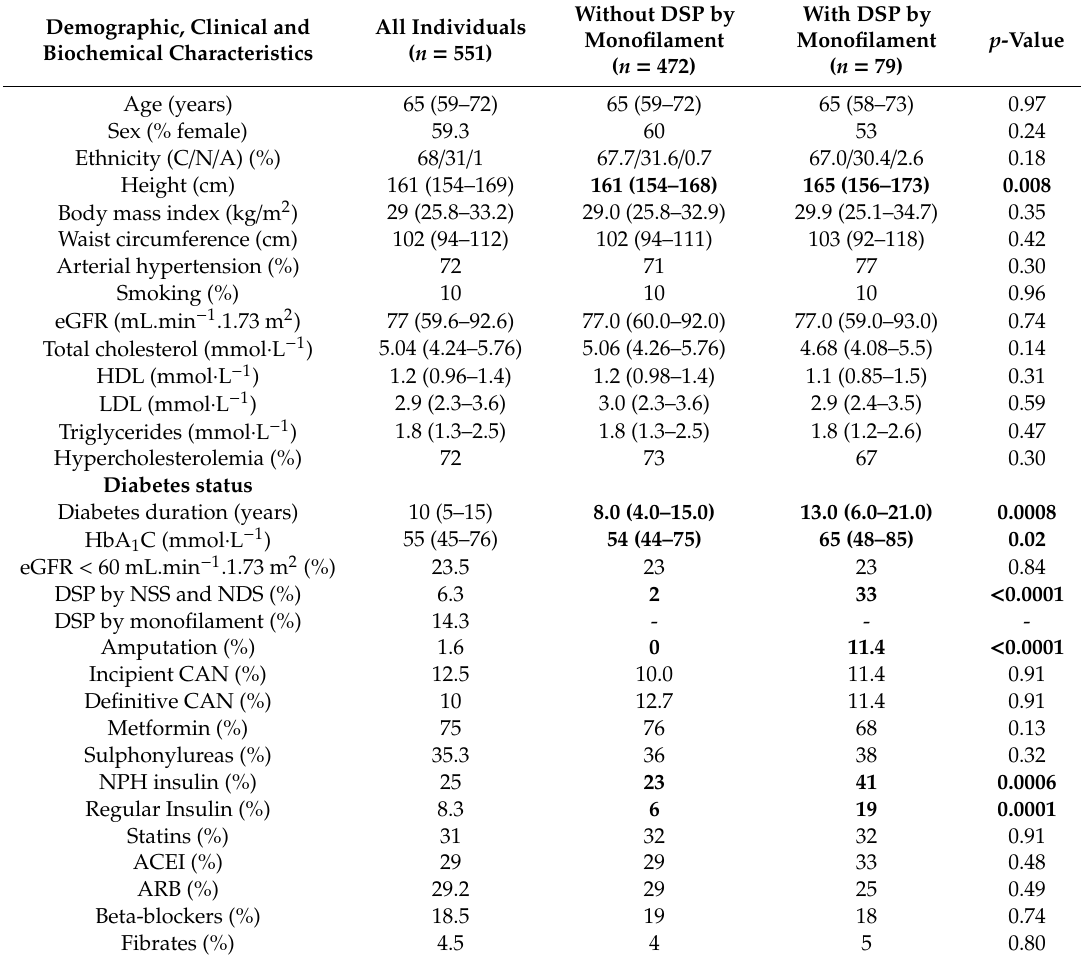
Table 1. Characteristics of individuals with type 2 diabetes according to the status of distal symmetric polyneuropathy (DSP) as evaluated by the